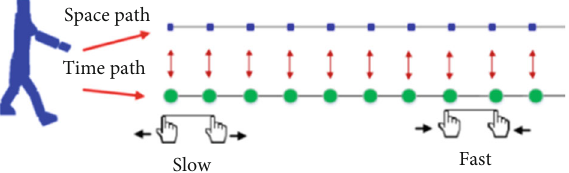
Figure 3: Spatial track and temporal track of each character.